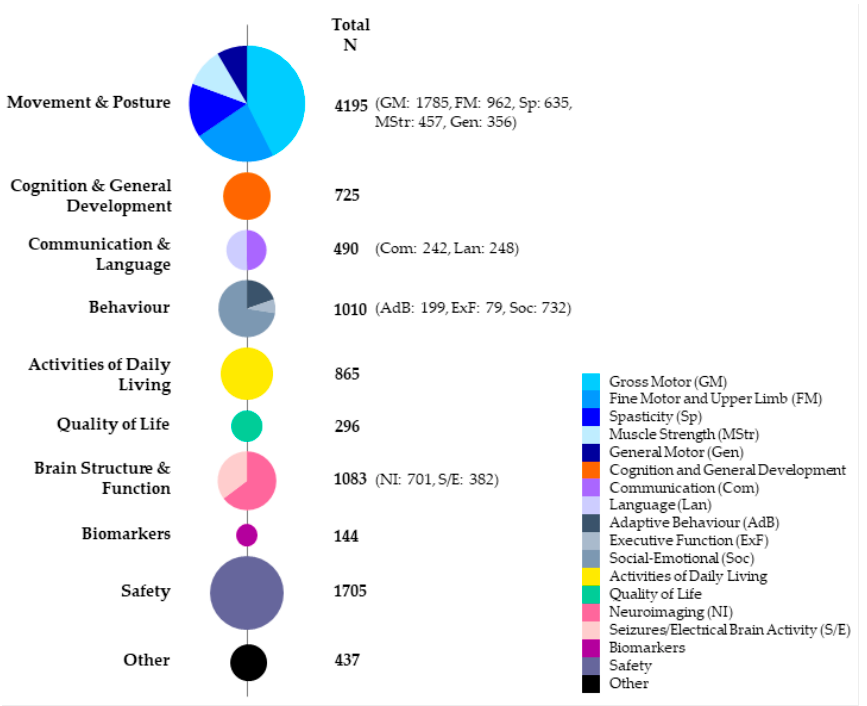
Figure 2. Number of participants assessed for each outcome category and sub-category across all included studies. N, number of participants. Table 2. Outcome instruments used in cerebral palsy cell therapy studies with